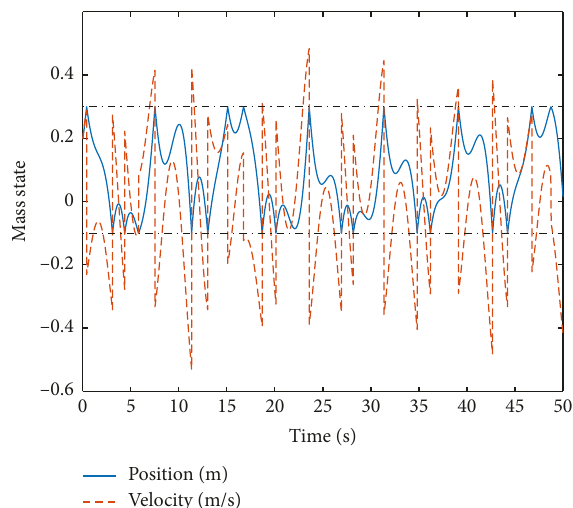
Figure 2: Temporal evolution of the mass position of the double- sided 1-DoF impacting mechanical oscillator for w � 0 . 8.